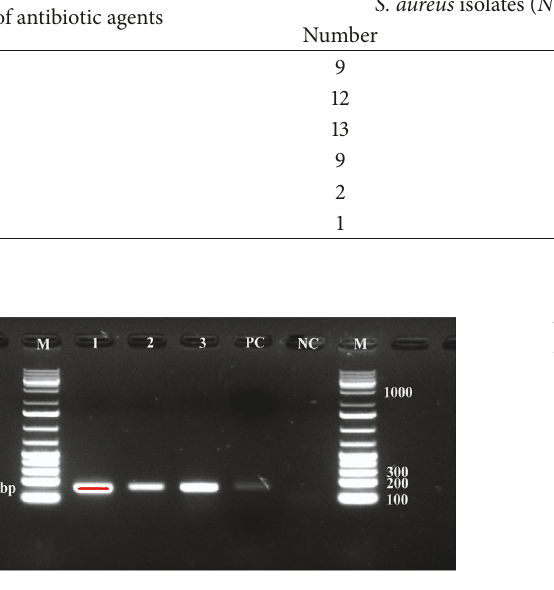
Figure 2: PCR detection of mecA gene in coagulase-negative S. aureus and coagulase-negative staphylococci isolates: PCR products showing mecA gene at 147-bp. Lane 1: coagulase-negative Staphylococci mecA positive; lanes 2 and 3: coagulase-negative S. aureus mecA positive; PC: positive control; NC: negative control; M: DNA